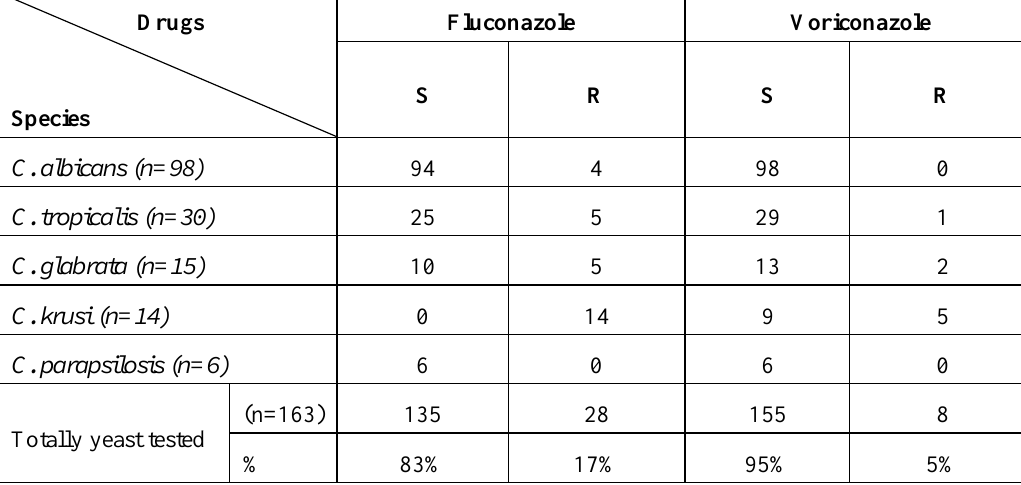
Table 3. Distribution of Candida species according azole susceptibility pattern.